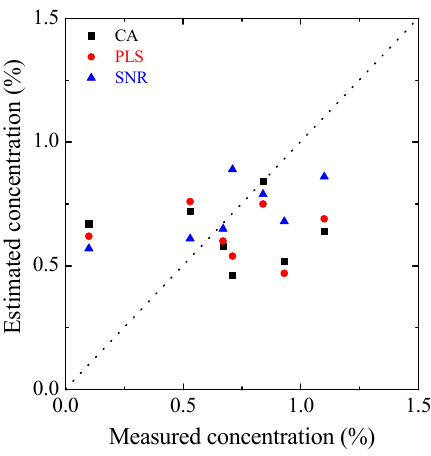
Figure 13. Estimated sulfur concentration with CA, PLS, and SNR.